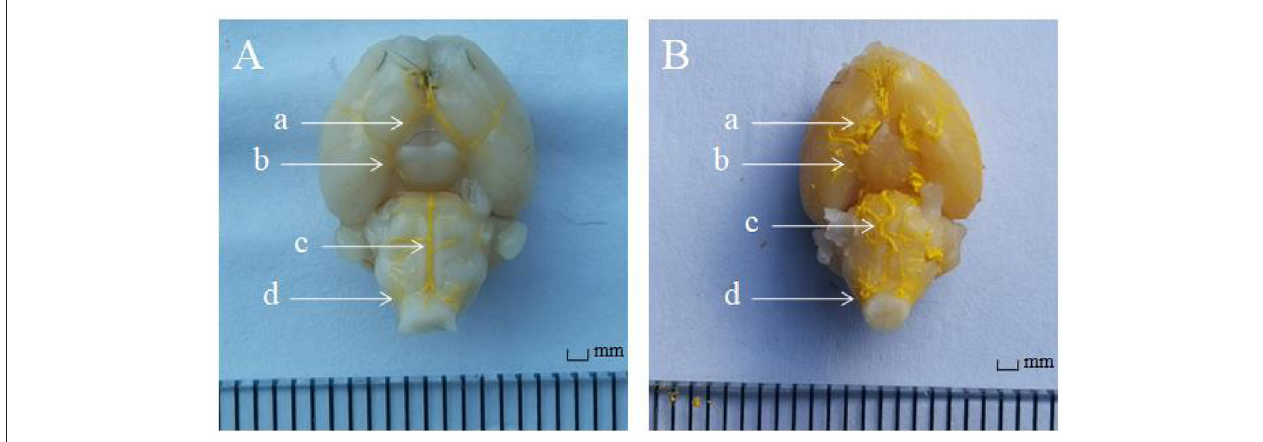
FIGURE 2 | The angiography of FlowTech MICROFIL of intracranial vessels. (A) In the control group ( n = 22), the intracranial vessels were smooth and normal. (B) In the experimental group ( n = 19), the intracranial arteries were elongated and tortuous. Anterior cerebral artery A1 segment (a arrow), posterior communicating artery (b arrow), basilar artery (c arrow), and vertebral artery (d arrow).